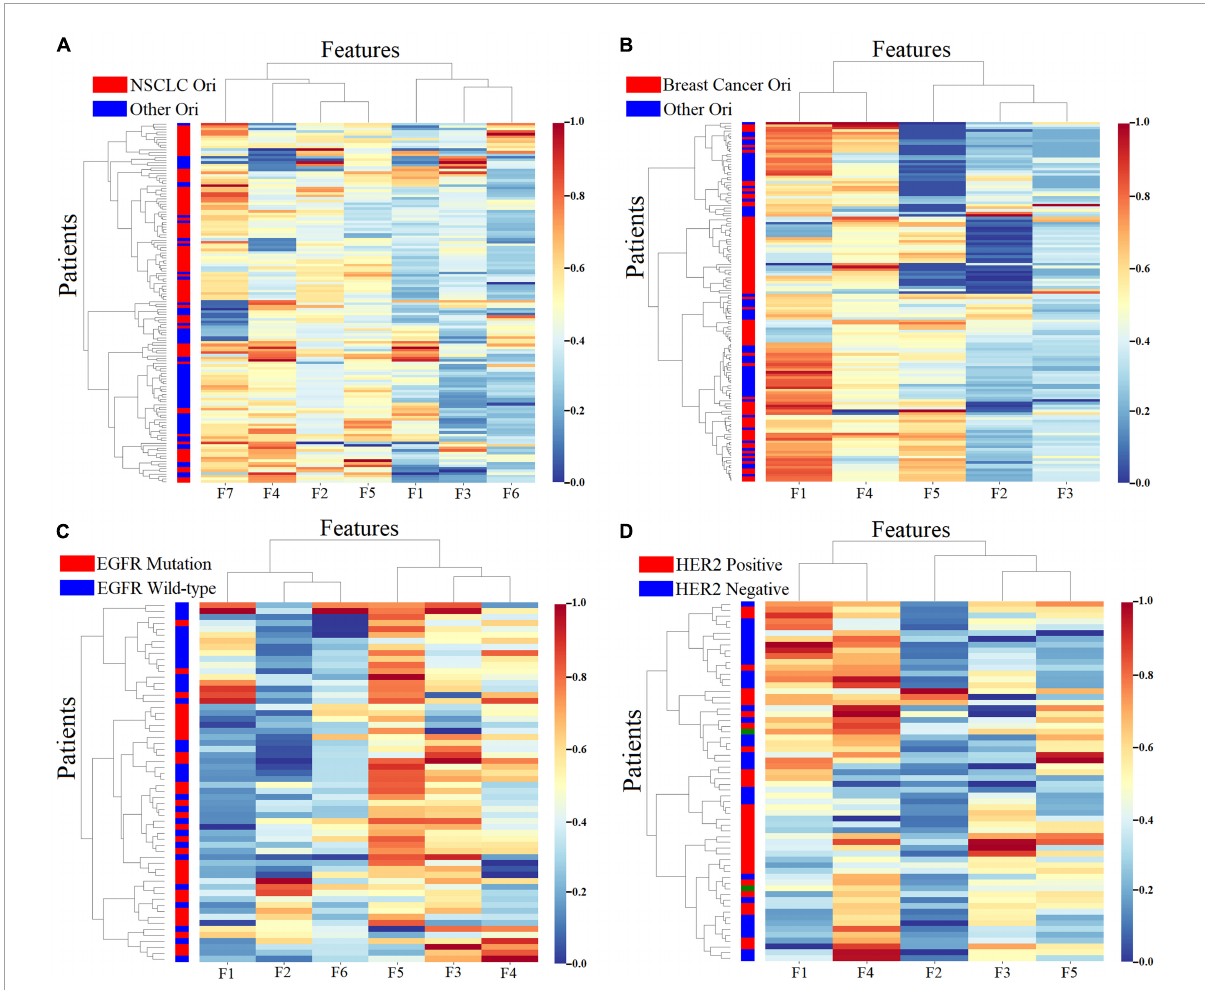
FIGURE6 Unsupervised cluster analysis of the selected features for predicting the NSCLC originated metastasis (A) , breast cancer originated metastasis (B) , EGFR mutation status (C) and HER2 status (D) . The x -axis represents the selected features with the highest predictive values. The y -axis represents all patients with brain